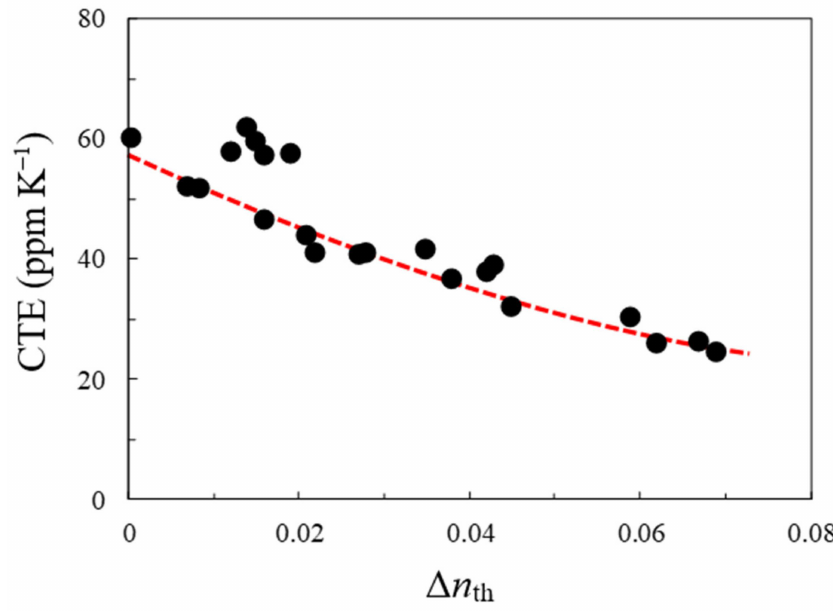
Figure 11. Relationship between the birefringence ( ∆ n th ) and CTE of the PI films examined in this